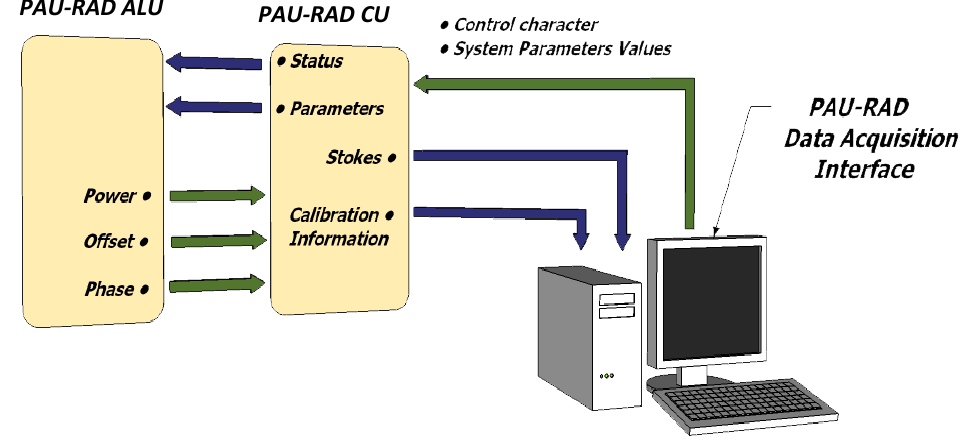
Figure 11. ALU–CU-interface PC data flux